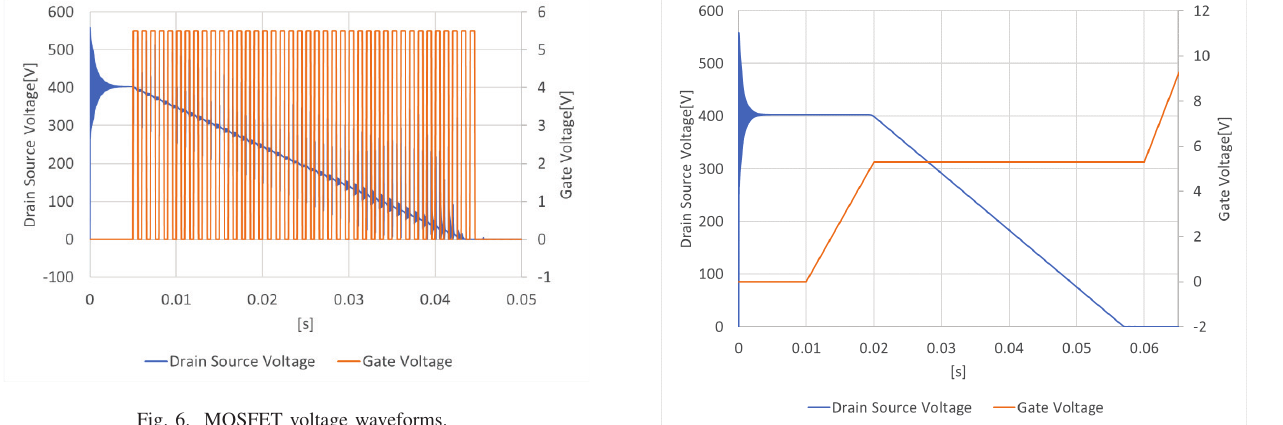
Fig. 6. MOSFET voltage waveforms.